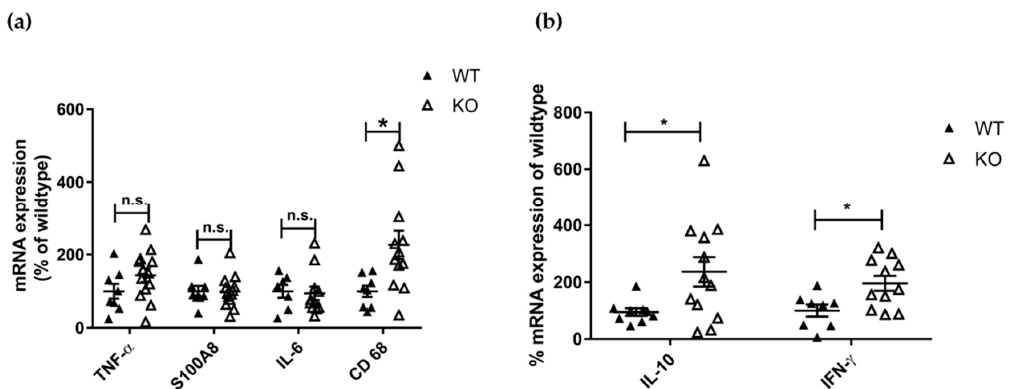
Figure 3. Analysis of mRNA expression of disease-relevant markers in the kidneys of 19-week-old female MRL- Fas lpr KSRP − / − mice compared to MRL-Fas lpr KSRP +/+ mice. RNA was isolated from the kidneys ( a , b ) of 19-week-old female MRL-Fas lpr KSRP − / − mice (KO) and MRL-Fas lpr KSRP +/+ mice (WT). The mRNA expression of TNF- α , S100A8, IL-6, CD68, IL- 10 and IFN- γ was analyzed by qRT-PCR and normalized to the mRNA expression of Pol2a. Data presented are the mean ± SEM of the relative mRNA expressions based on WT (100%) with 8 to 12 animals per genotype (* p < 0.05; n.s.: not significantly different from WT, t -test).